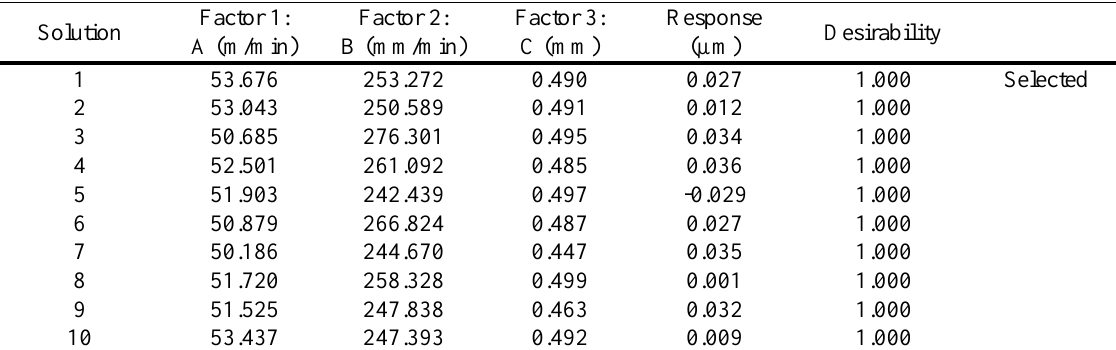
Table 5. Value of design parameters for optimizing the